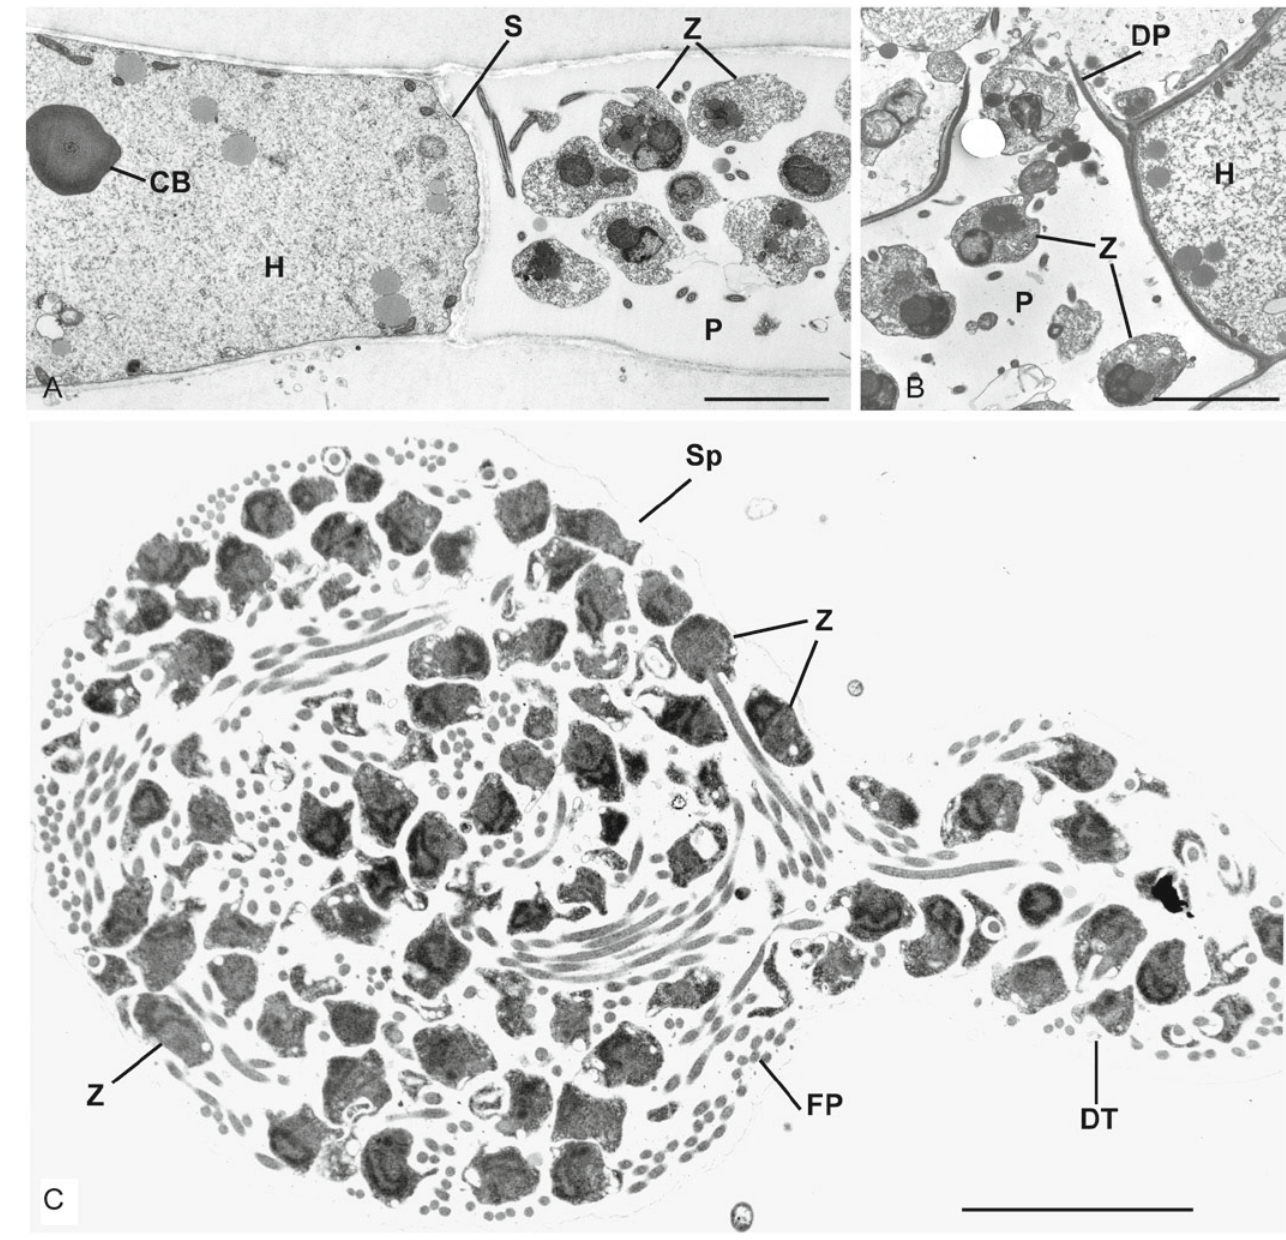
Fig. 5. (cid:2)B(cid:4)(cid:6)(cid:18)(cid:23)(cid:13)(cid:8)(cid:13)(cid:21)(cid:2)"(cid:4)(cid:4)(cid:7)(cid:18)(cid:4)(cid:10)(cid:13)(cid:2)(cid:26)(cid:4)(cid:10)(cid:6)(cid:9)(cid:8)(cid:11)(cid:4)(cid:17)(cid:2)(cid:11)(cid:17)(cid:2) Rozella . A. (cid:2)(cid:130)(cid:4)(cid:4)(cid:7)(cid:18)(cid:4)(cid:10)(cid:13)(cid:7)(cid:2)(cid:4)(cid:26)(cid:2) R. allomycetis [strain CSF 55; Powell et al. 2017] in host Allomyces arbuscula ; septum separating host from parasite was induced by parasite. B. (cid:2)(cid:130)(cid:4)(cid:4)(cid:7)(cid:18)(cid:4)(cid:10)(cid:13)(cid:7)(cid:2)(cid:4)(cid:26)(cid:2) R. allomycetis [strain CSF 55] being released through a discharge pore. C. (cid:2)(cid:130)(cid:4)(cid:4)(cid:7)(cid:18)(cid:4)(cid:10)(cid:13)(cid:7)(cid:2)(cid:4)(cid:26)(cid:2) R. multimorpha [strain JEL 883; Letcher et al . 2018] in host Pythium catenulatum ; some spores are in the (cid:21)(cid:11)(cid:7)(cid:19)(cid:14)(cid:9)(cid:10)(cid:25)(cid:13)(cid:2)(cid:8)(cid:5)(cid:12)(cid:13)(cid:28)(cid:2)U(cid:12)(cid:12)(cid:10)(cid:13)%(cid:11)(cid:9)(cid:8)(cid:11)(cid:4)(cid:17)(cid:7)$(cid:2)BO(cid:29)(cid:2)(cid:19)(cid:4)(cid:17)(cid:19)(cid:13)(cid:17)(cid:8)(cid:10)(cid:11)(cid:19)(cid:2)(cid:12)(cid:4)(cid:21)(cid:22)(cid:30)(cid:2)N(cid:133)(cid:29)(cid:2)(cid:21)(cid:11)(cid:7)(cid:19)(cid:14)(cid:9)(cid:10)(cid:25)(cid:13)(cid:2)(cid:18)(cid:4)(cid:10)(cid:13)(cid:30)(cid:2)N=(cid:29)(cid:2)(cid:21)(cid:11)(cid:7)(cid:19)(cid:14)(cid:9)(cid:10)(cid:25)(cid:13)(cid:2)(cid:8)(cid:5)(cid:12)(cid:13)(cid:30)(cid:2)(cid:129)(cid:133)(cid:29)(cid:2)!(cid:9)(cid:25)(cid:13)(cid:23)(cid:23)(cid:9)(cid:10)(cid:2)(cid:18)(cid:4)(cid:4)(cid:23)(cid:30)(cid:2)\(cid:29)(cid:2)(cid:14)(cid:4)(cid:7)(cid:8)(cid:30)(cid:2)(cid:133)(cid:29)(cid:2)(cid:18)(cid:9)(cid:10)(cid:9)(cid:7)(cid:11)(cid:8)(cid:13)(cid:30)(cid:2)Q(cid:29)(cid:2)(cid:7)(cid:13)(cid:18)(cid:8)(cid:5)(cid:6)(cid:30)(cid:2)